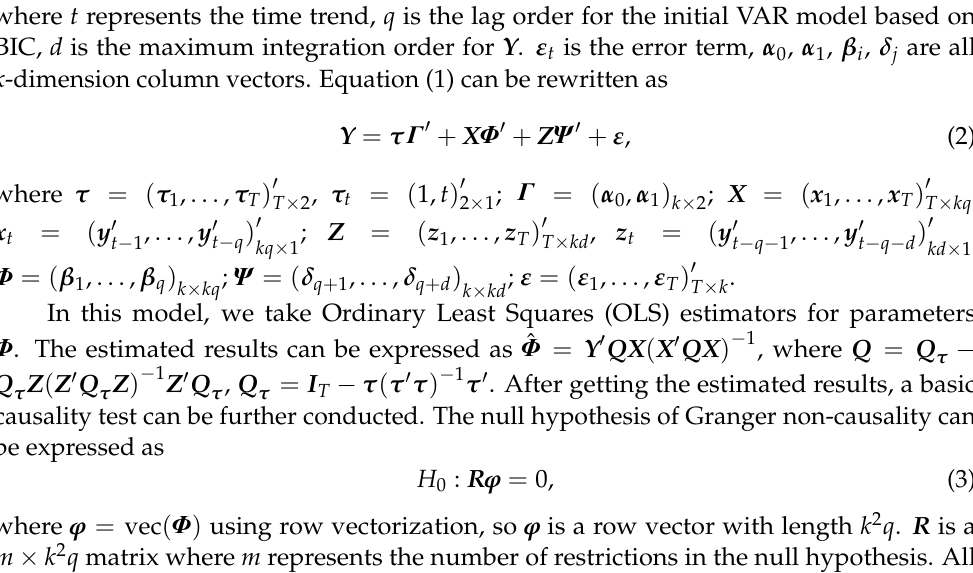
Table 2. Descriptive